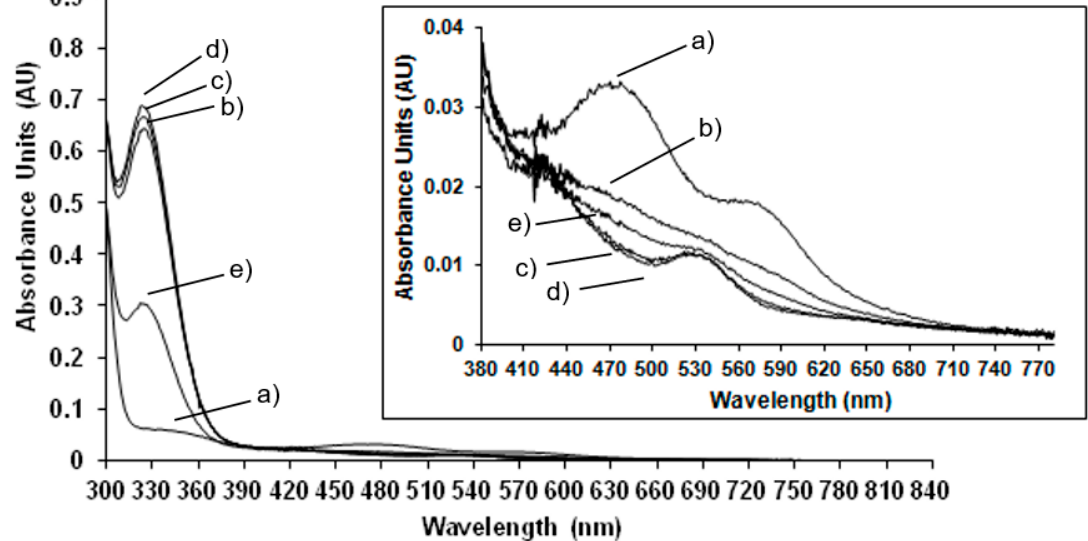
Figure 2. Room temperature UV-Vis spectra of ( a ) native NDO; ( b ) reduced NDO immediately after the addition of sodium dithionite (1.25 mM), t0 min; ( c ) t1 min; ( d ) t5 min; and ( e ) t10 min. In the inset: magnification of the spectra in the range of 380 to 800 nm.